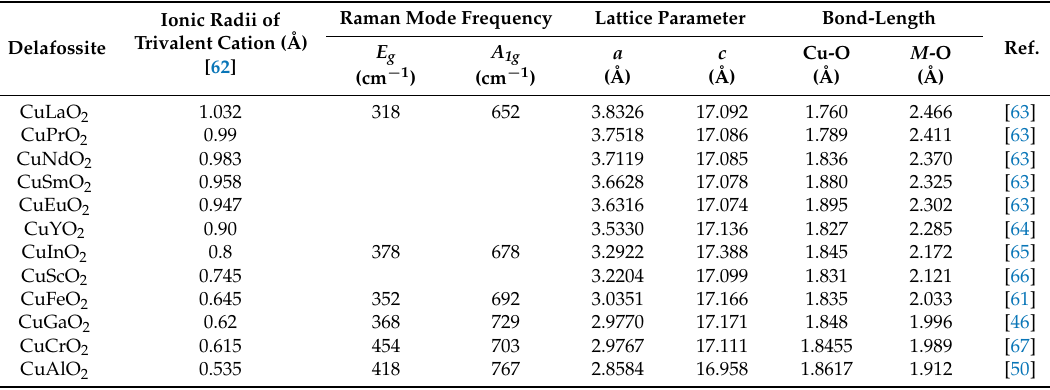
Table 2. Ionic radii, Raman mode frequencies, lattice parameters and bond-lengths for various copper delafossite